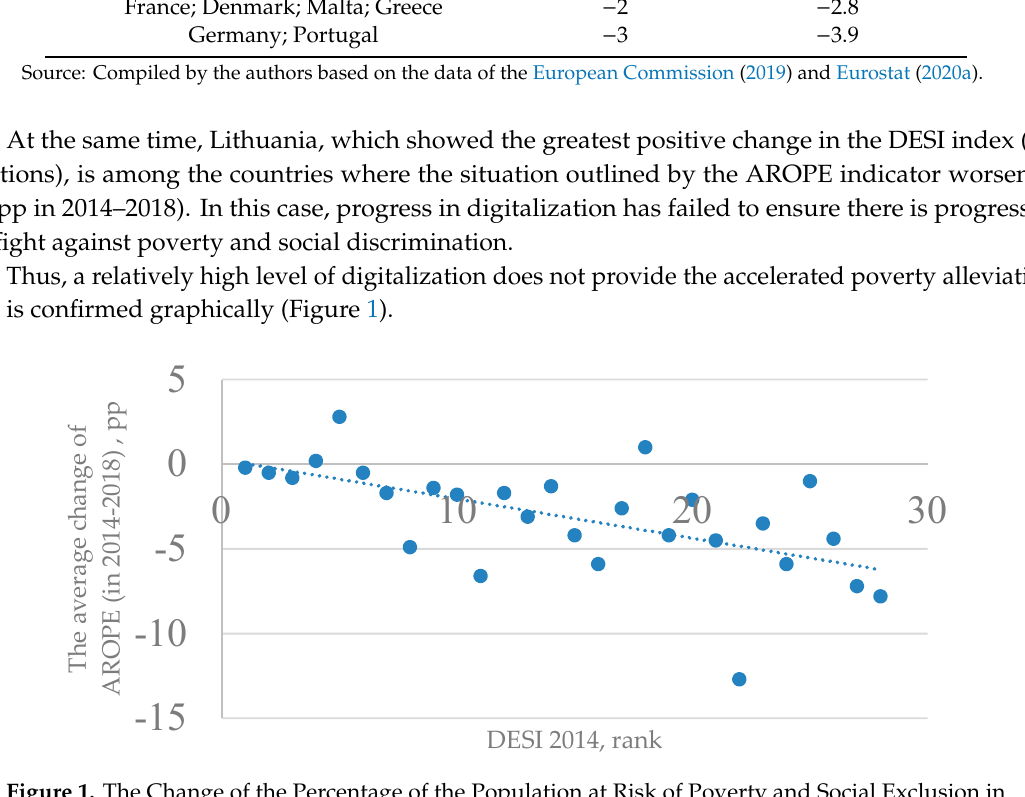
Figure 1. The Change of the Percentage of the Population at Risk of Poverty and Social Exclusion in the EU Countries in 2014–2018 against their positions in the DESI Ranking in 2014. Source: Compiled